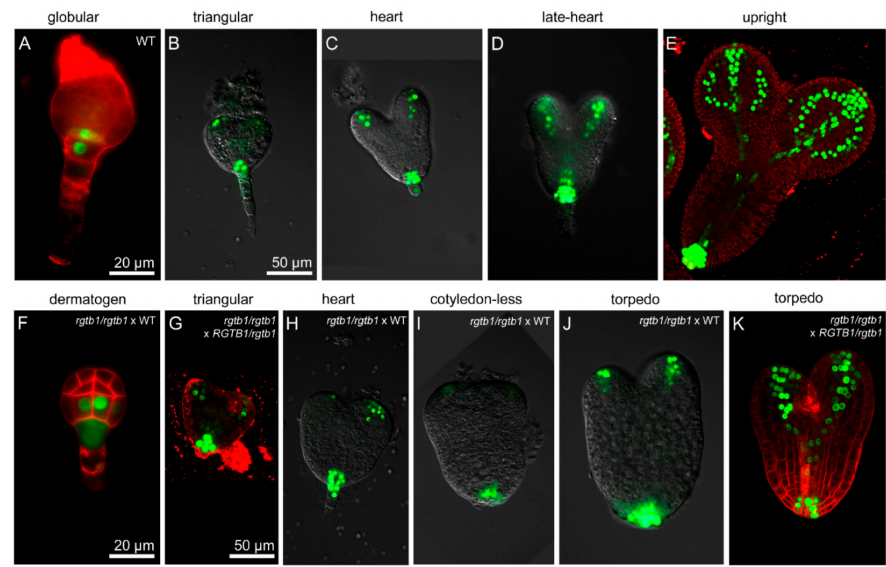
Figure 7. Deformed embryos in rgtb1 plants show diffuse auxin maxima. Auxin maxima monitored by the expression of the pDR5rev :3xVenus-NLS reporter (green) in embryos formed on WT or rgtb1 plants. Auxin is abundant in a basal half of the globular embryos ( A , F ). Strong auxin maxima form in the prospective cotyledon tips and prospective root meristem at the triangular stage of the embryos ( B , G ). Starting from the early heart stage auxin maxima at the tips of the cotyledons become more diffuse and weaker in embryos formed on rgtb1 plants ( H – J ) compared to embryos formed on WT plants ( C , D ). Auxin maximum in the embryo basal part remains strong, regardless of the genotype of the mother plant ( B – D , G – J ). Note the larger size, wider middle part of the embryo and shorter cotyledons in the rgtb1 -formed embryos ( H – J ). rgtb1 -formed embryos are delayed in cotyledon vasculature formation ( J , K ) in comparison to WT embryos ( D , E ). ( E – G , K ) CSLM images, pDR5rev :3xVenus-NLS (green) counterstained with FM4-64 (red) to visualize cell contours. ( A – D , H – J ) Fluorescence microscopy, pDR5rev :3xVenus-NLS (green). The scale bar is 20 µ m for images ( A , F ) and 50 µ m for all the other